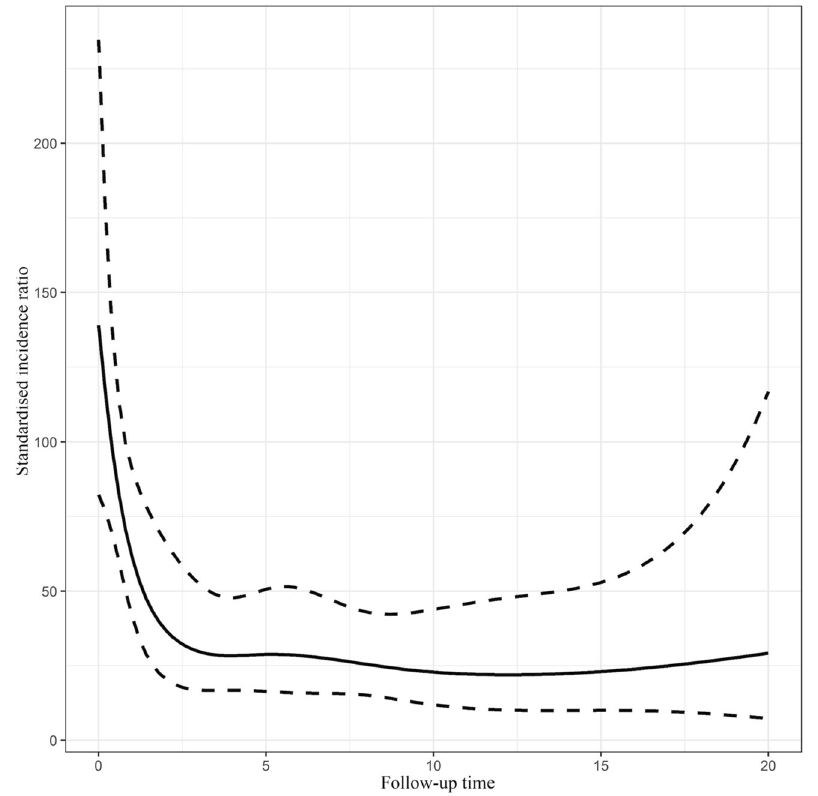
Figure 4. Change in standardised incidence ratio per year of